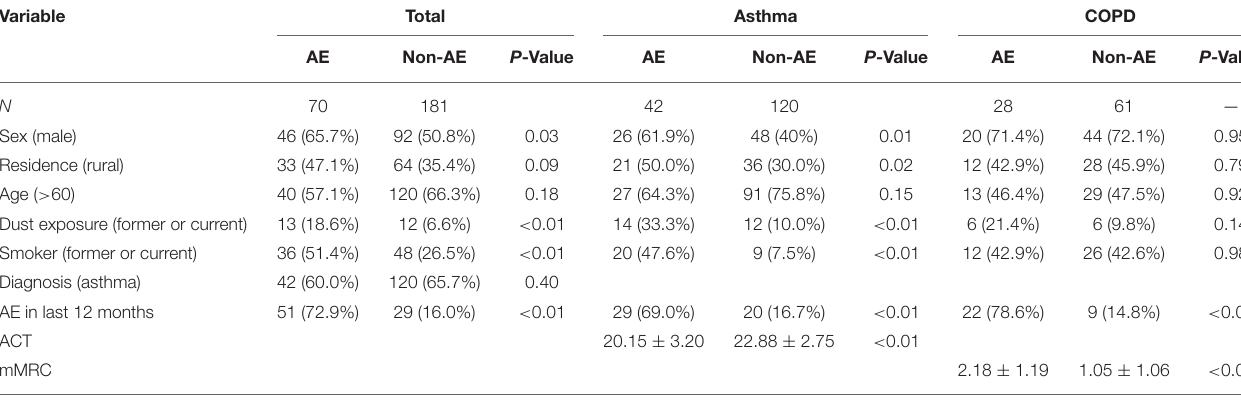
TABLE 4 | Comparisons between AE and non-AE patients during the COVID-19 pandemic (2020).